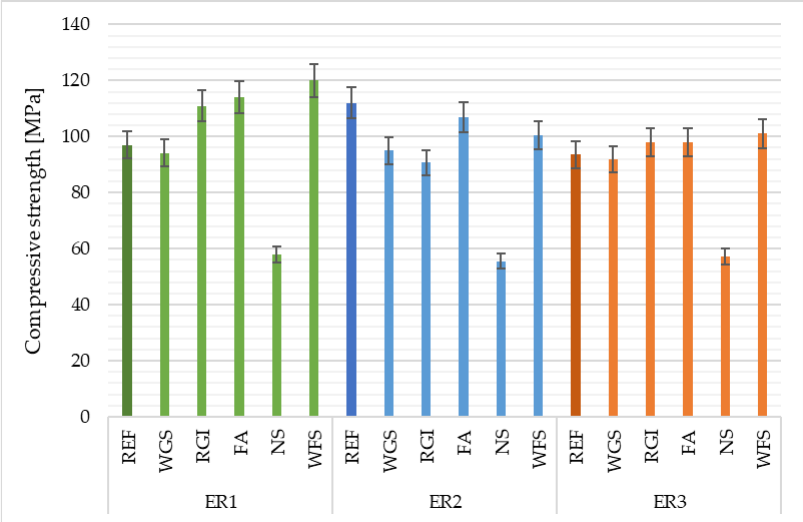
Figure 5. Results of compressive strength of epoxy composites depending on the type of filler and epoxy binder used.